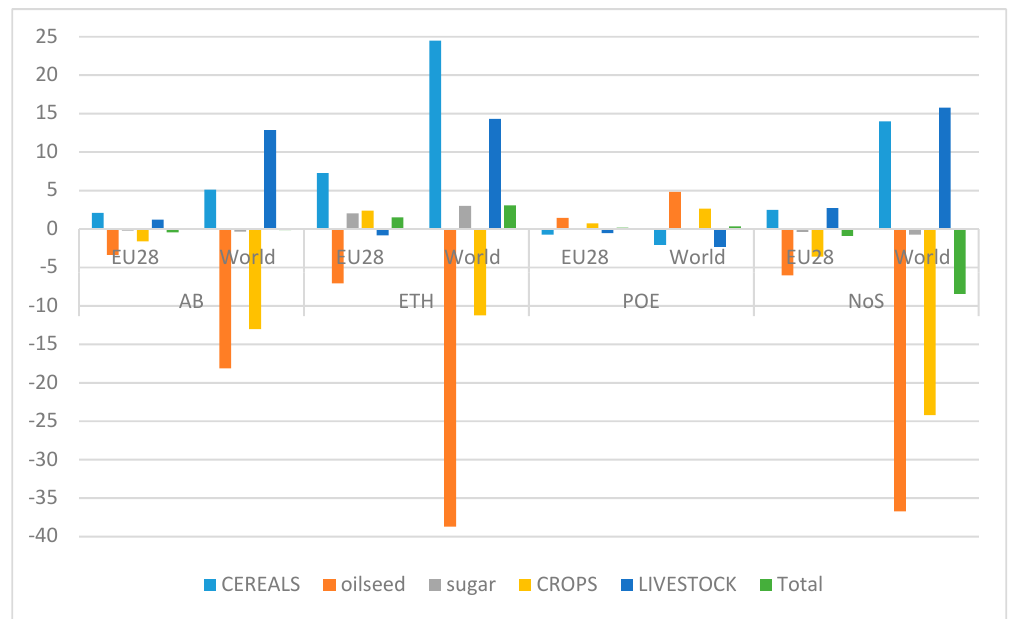
Figure 2. Impacts on land usage (1000 km 2 ) vs. baseline. (Block capitals denote aggregate activities).